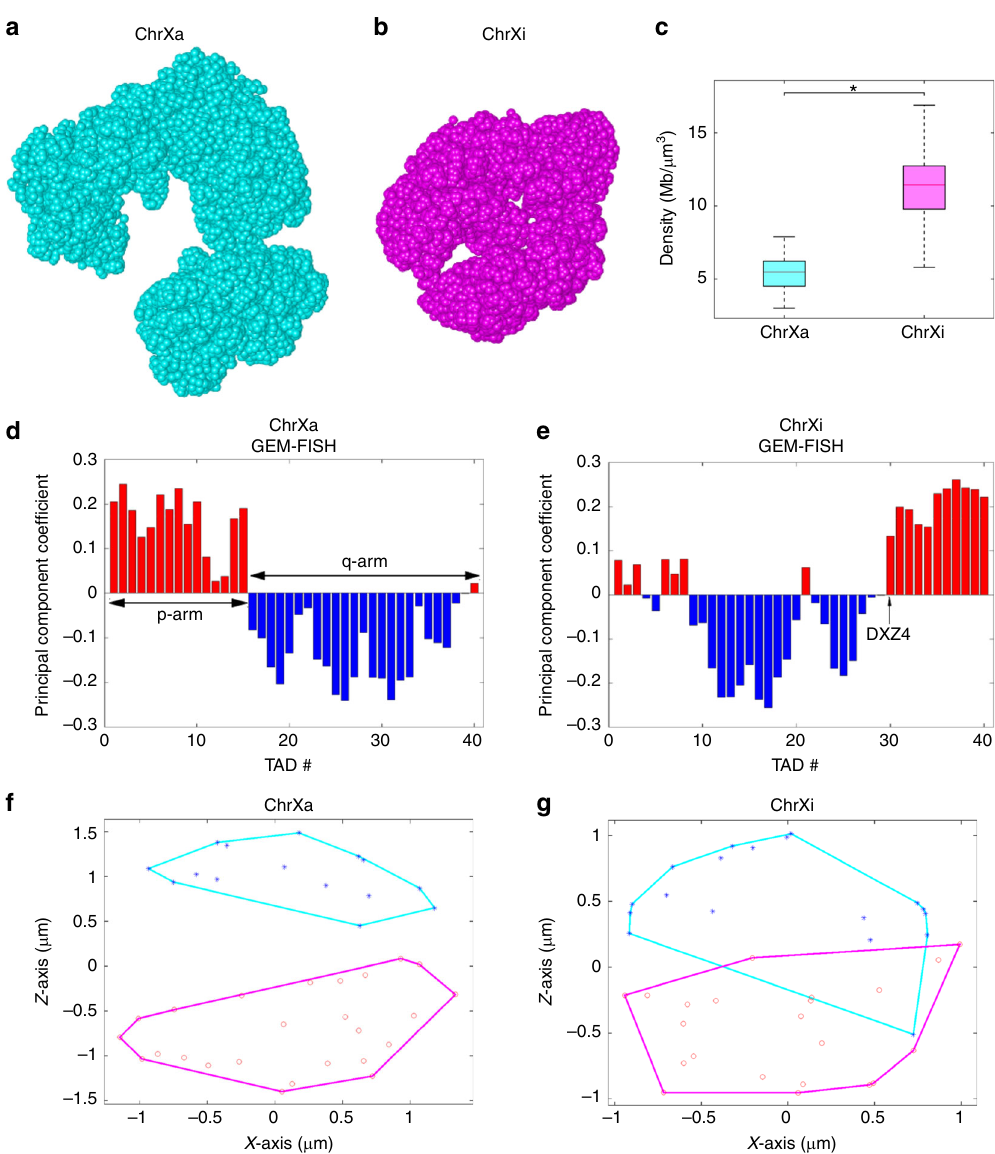
Fig. 4 The modeling results of GEM-FISH for the human X-Chromosome (including both active state ChrXa and inactive state ChrXi). a , b Visualization of the fi nal 3D models of ChrXa ( a ) and ChrXi ( b ) in UCSF Chimera 61 . ( c ) Comparison of the compactness of TADs between the 3D models of active (ChrXa) and inactive (ChrXi) states of human X-Chromosome. N = 40 TADs for both Chrs Xa and Xi. * p -value < 10 − 13 , one-tailed Wilcoxon rank-sum test. d , e The assignment of TADs of ChrXa ( d ) and ChrXi ( e ) to the A/B compartments. f , g Projection of the 3D convex hull plots of the A and B compartments of ChrXa ( f ) and ChrXi ( g ) to the XZ plane. For the boxplots, the top and bottom lines of each box represent the 75th and 25th percentiles of the samples, respectively. The line inside each box represents the median of the samples. The upper and lower lines above and below the boxes are the